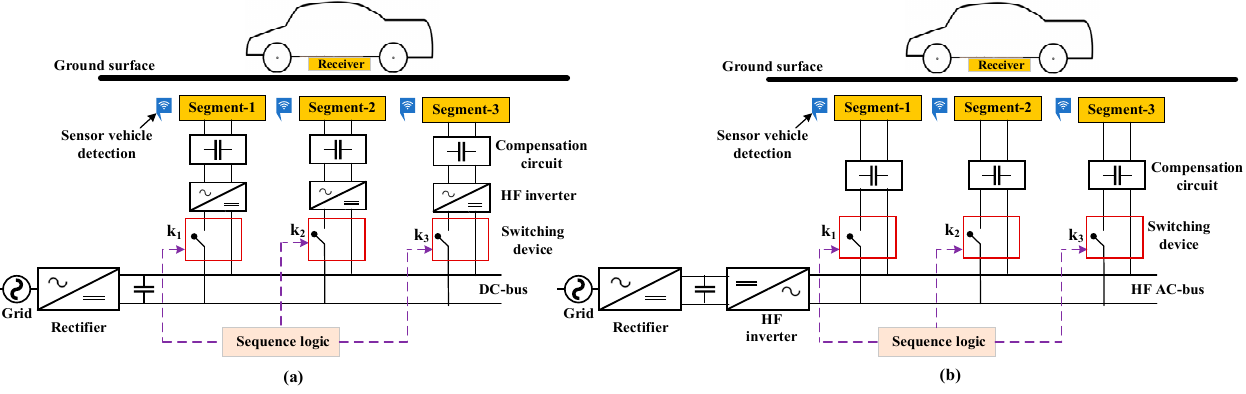
Figure 7. Supply arrangements for segmented transmitter of DIPT system ( a ) using a common dc-bus and ( b ) using a common HF ac-bus.